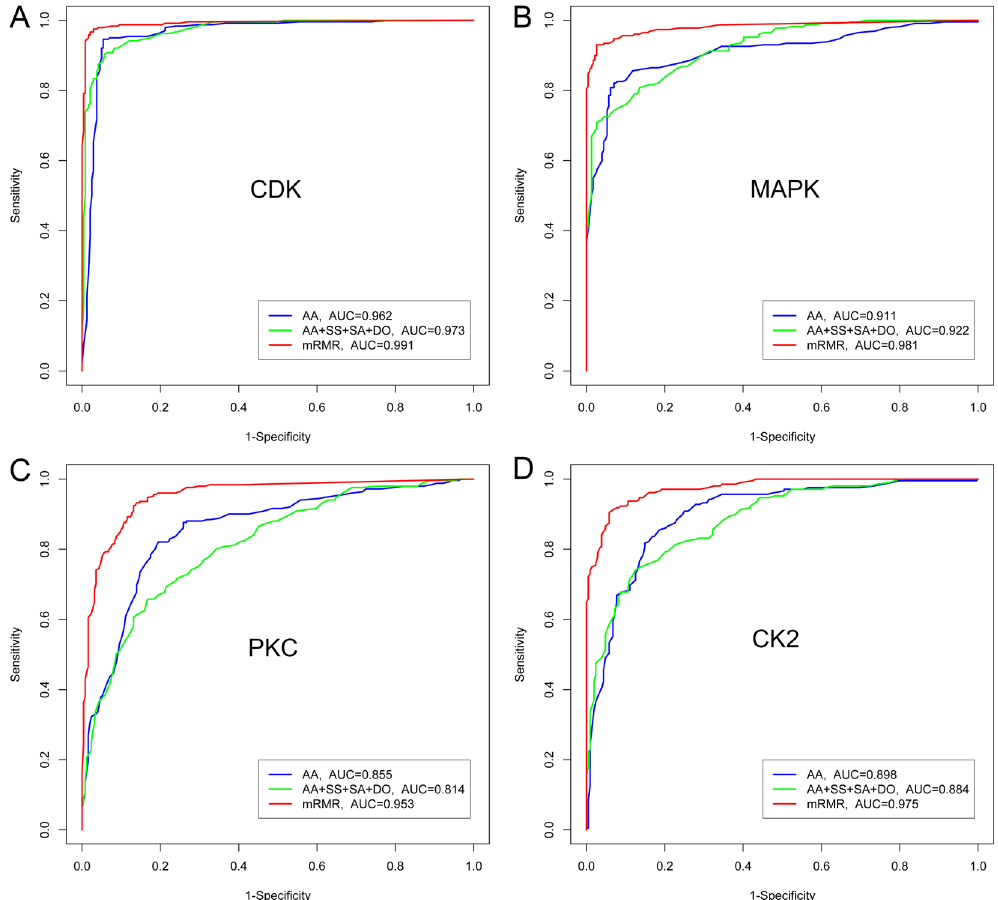
Figure 3. Phosphorylation site prediction. ROC curves for phosphorylation site prediction of three different sequence-encoding schemes: AA (amino acid sequence encoding), AA + SS + SA + DO (amino acid sequence + secondary structure + solvent accessibility + native disorder, without feature selection), and mRMR (mRMR feature selection based on all the extracted initial features), evaluated using 5-fold cross-validation tests on the benchmark datasets. Data represent ( A ) CDKs, ( B ) MAPKs, ( C ) PKC, and ( D )